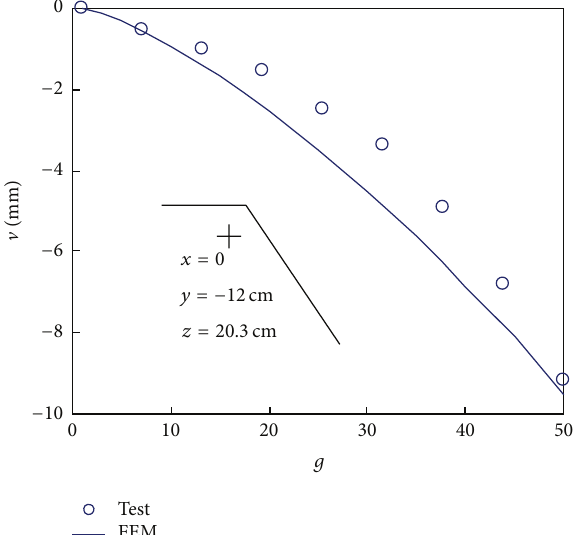
Figure 6: Vertical displacement history of a typical point by numerical analysis and test results. v : vertical displacement; g :